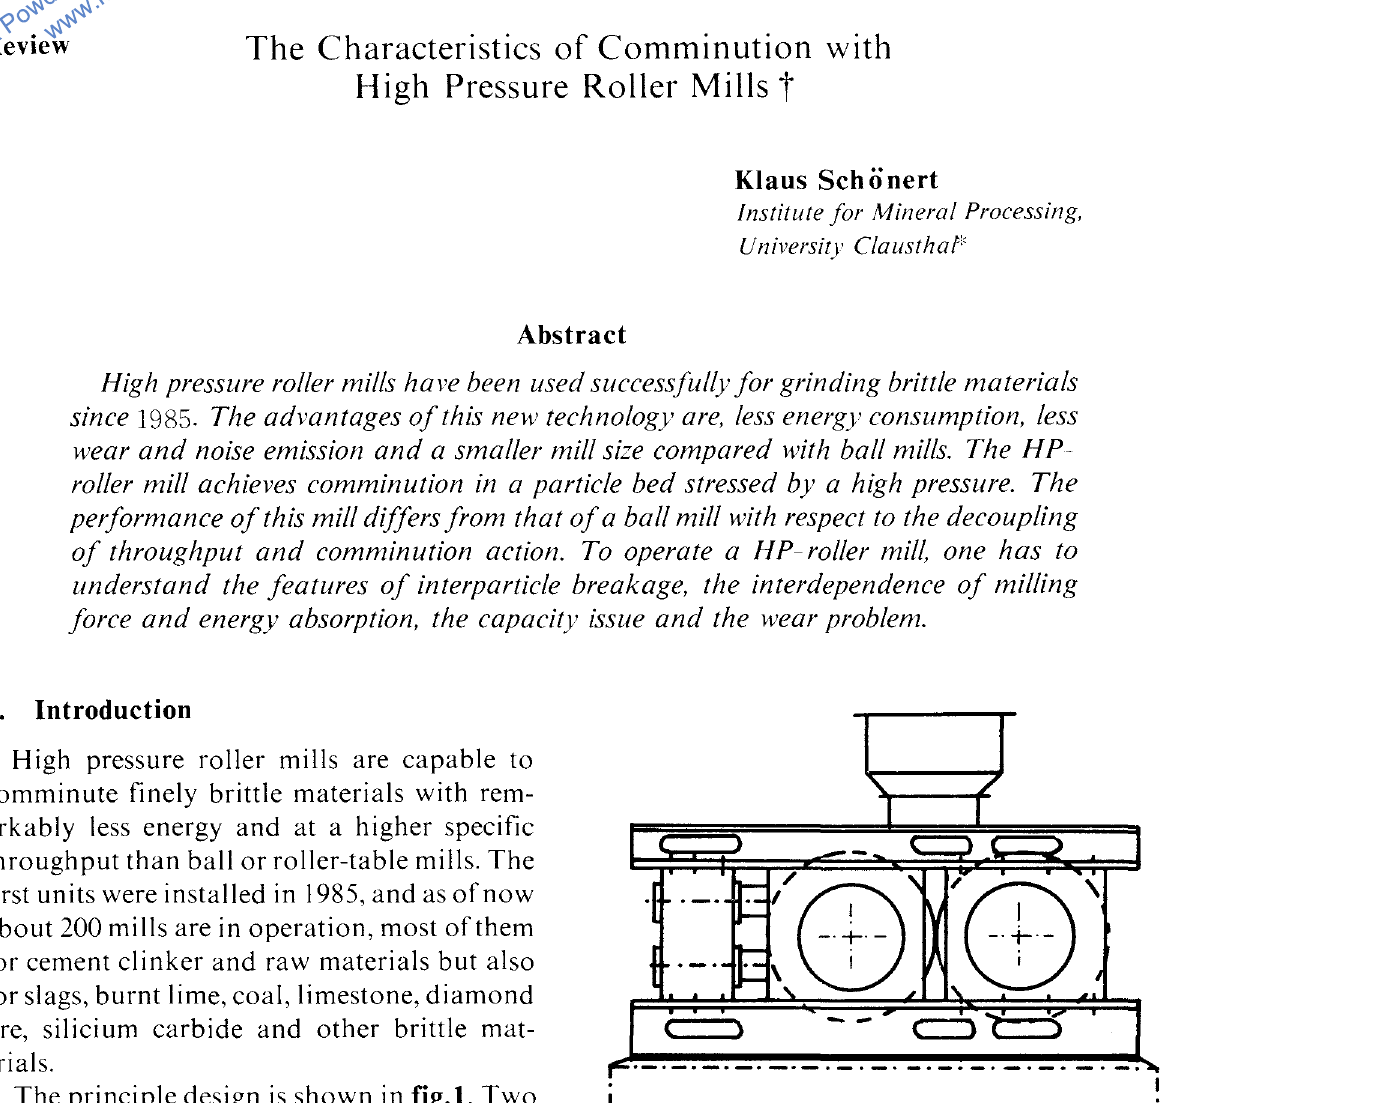
Fig. I Sketch of a HP-roller mill tion of flakes. The agglomerates are disin tegrated in a following hammer-, impact- or ball mill. Then the material is sent to a class ifier, and the coarse portion is